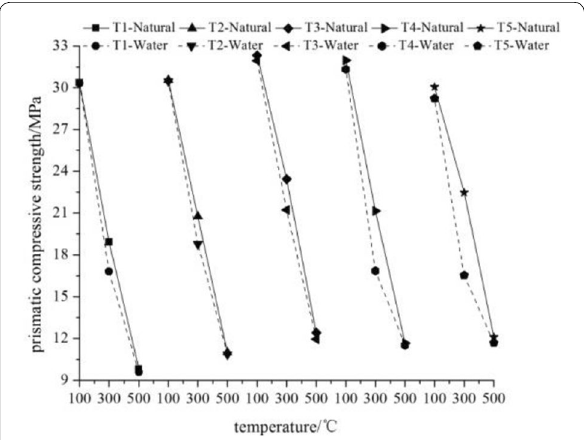
Fig. 13 Relation between the prismatic compressive strength of concrete produced with desert sand and temperature under different